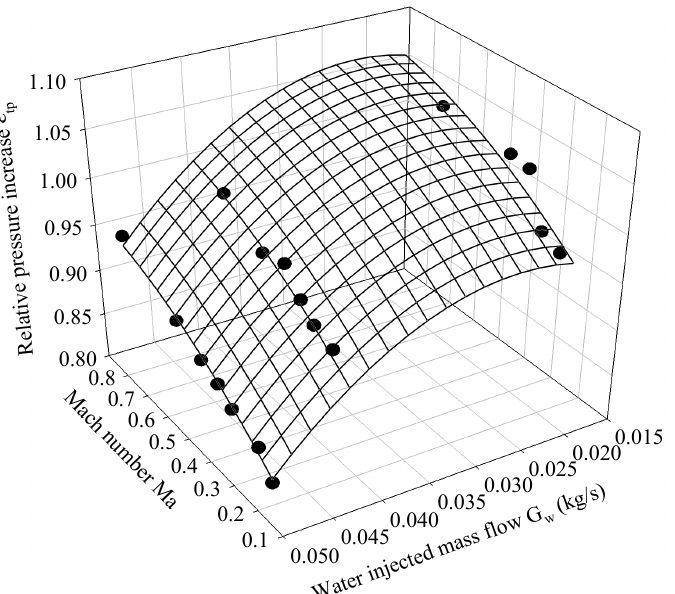
Figure 7. Experimental dependencies of the relative pressure increase ε tp = P 2 /P 1 in the thermopres- sor flow part on the velocity airflow Ma numbers and water consumption on nozzles G w .